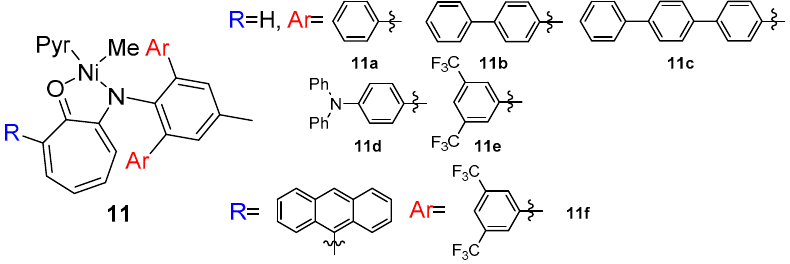
Figure 9. Neutral, single-component anilinotropone nickel catalysts 11a – f .